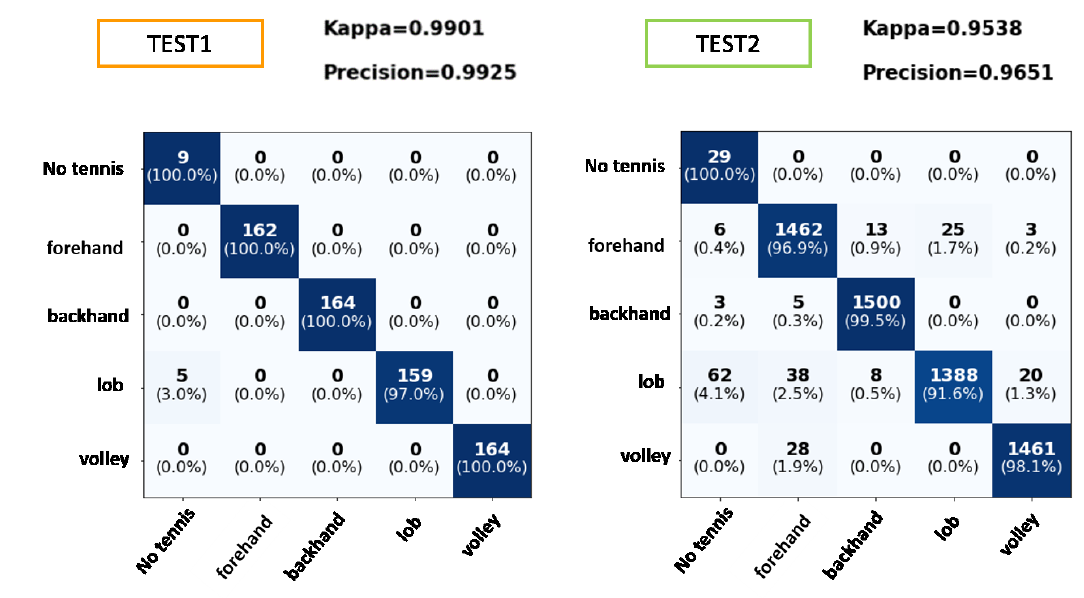
Figure 13. Confusion matrix for tennis strokes classification. TEST1: Data test set separated from training set. TEST2: Test set regarding with the player not introduced in training. Rows true label and columns the predicted